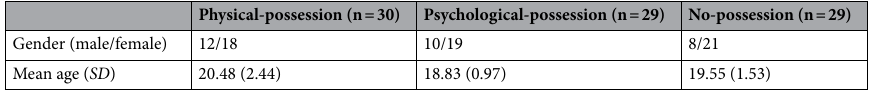
Table 1. Participants’ demographics in each possession condition.